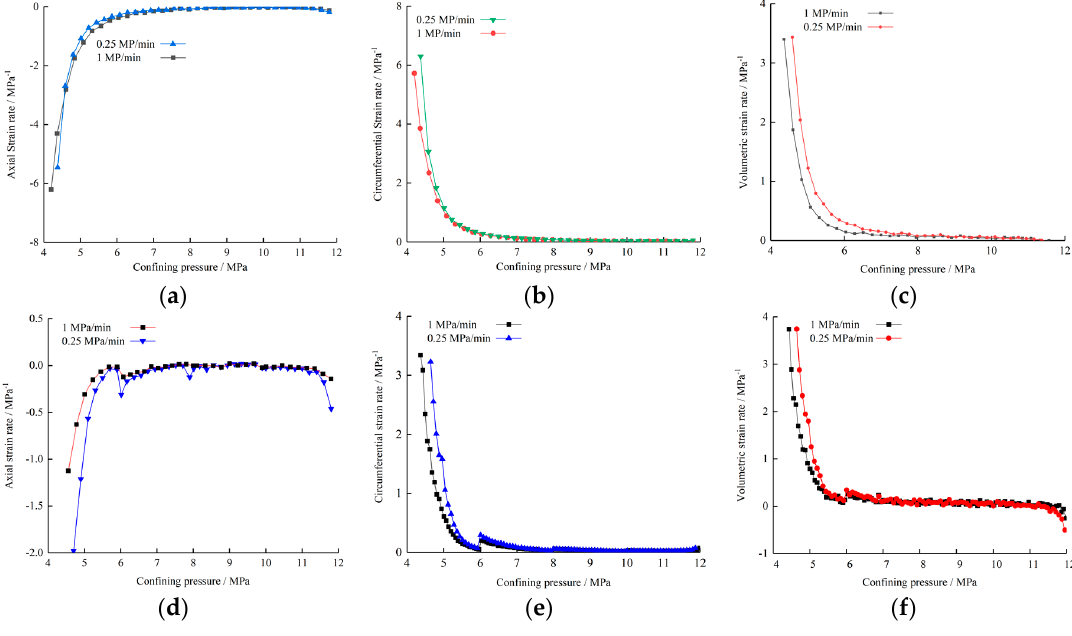
Figure 14. Strain rate of tectonic coal under different unloading rate. Continuous unloading path- ( a ) axial strain rate, ( b ) circumferential strain rate, ( c ) volume strain rate; Cyclic unloading path ( d ) axial strain rate, ( e ) circumferential strain rate, ( f ) volume strain rate.